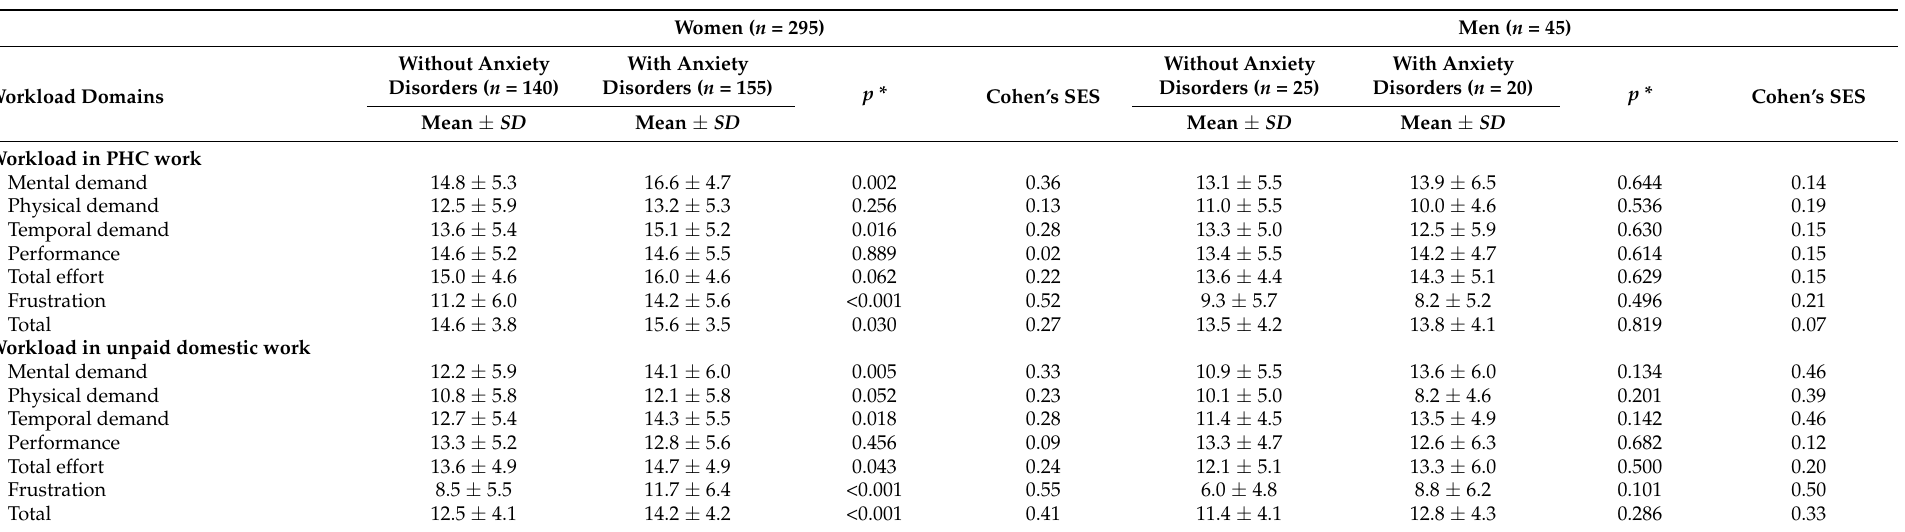
Table 3. Comparison according to the gender of the health care professionals in terms of PHC workload and unpaid domestic work according to the presence or absence of anxiety disorders. Women ( n =